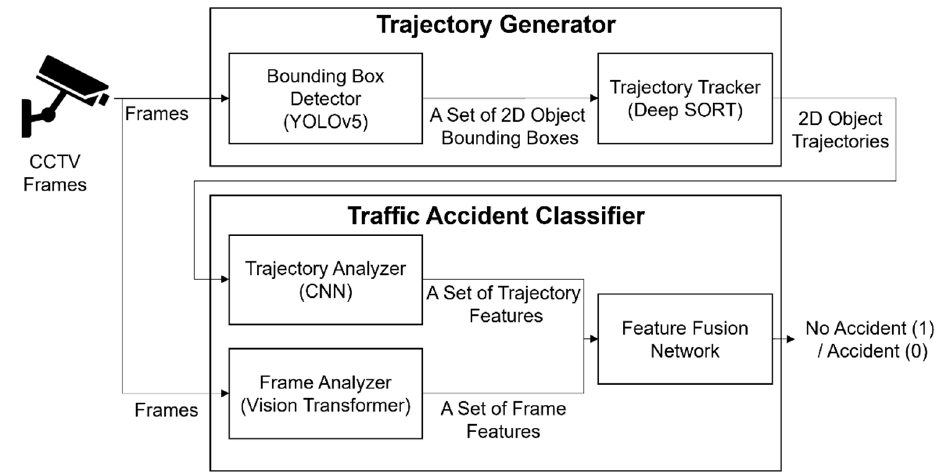
Figure 1. Processes of traffic accident classification with Trajectory Generator and Traffic Accident Classifier.